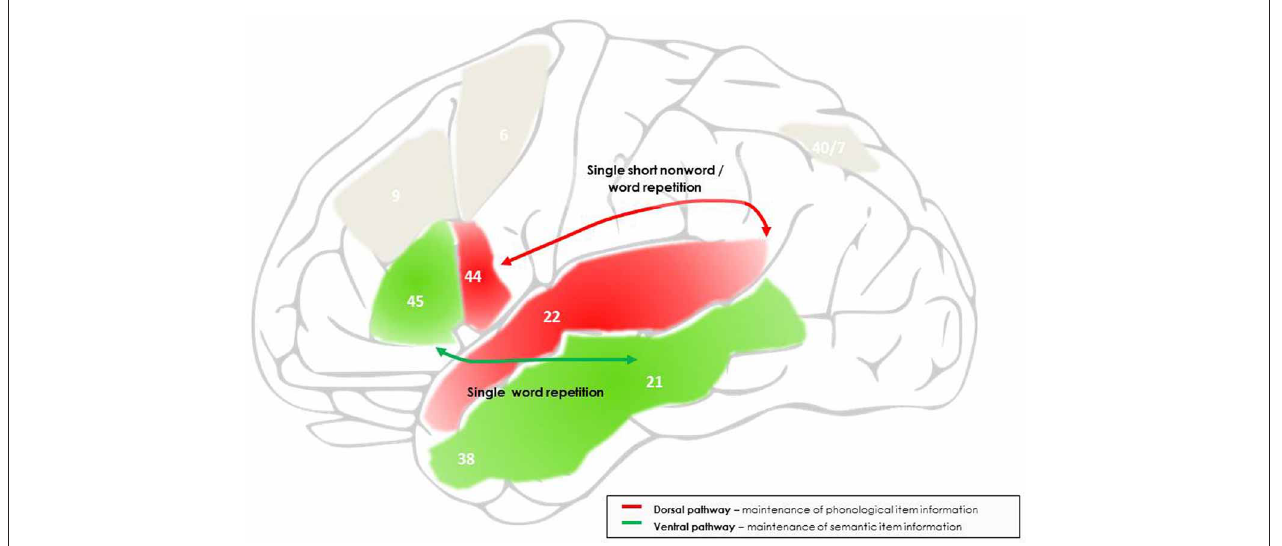
FIGURE 1 | Outline of the networks and processes proposed to support maintenance processes during single word and short non-word repetition. Maintenance during short non-word repetition is mainly supported by the dorsal language pathway, linking the superior and posterior temporal cortex to the posterior inferior frontal cortex, and, at the cognitive level, reflects temporary activation and interfacing of input and output phonological item representations. Maintenance of single word repetition is also supported by the dorsal language